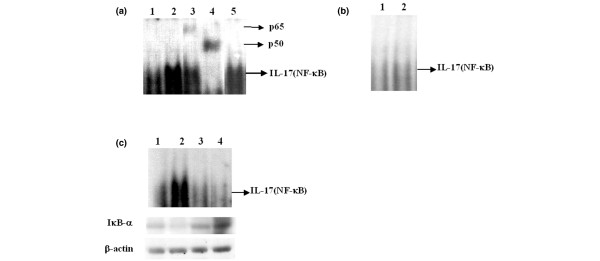
Effects of anti-CD3 plus anti-CD28 on NF-κB complex in nuclear extracts of rheumatoid arthritis (RA) peripheral blood mononuclear cells (PBMC) and normal PBMC. (a) NF-κB activity in the absence (lane 1) or presence (lane 2) of anti-CD3 plus anti-CD28 antibody; supershift assay of NF-κB site with antibodies against p65 (lane 3), p50 (lane 4) and c-Rel (lane 5). PBMC from patients with RA were stimulated with anti-CD3 plus anti-CD28 and were used for the supershift assay. (b) NF-κB activity in the absence (lane 1) or presence (lane 2) of anti-CD3 antibody plus anti-CD28 in normal PBMC. (c) NF-κB activity in the absence (lane 1) or presence (lane 2) of anti-CD3, anti-CD3 plus LY294002 (lane 3) or anti-CD3 plus pyrrolidine dithiocarbamate (PDTC; lane 4). Arrows denote a labeled oligonucleotide band shifted after NF-κB binding. The lower panel shows an immunoblot for IκB-α and actin at the same time.